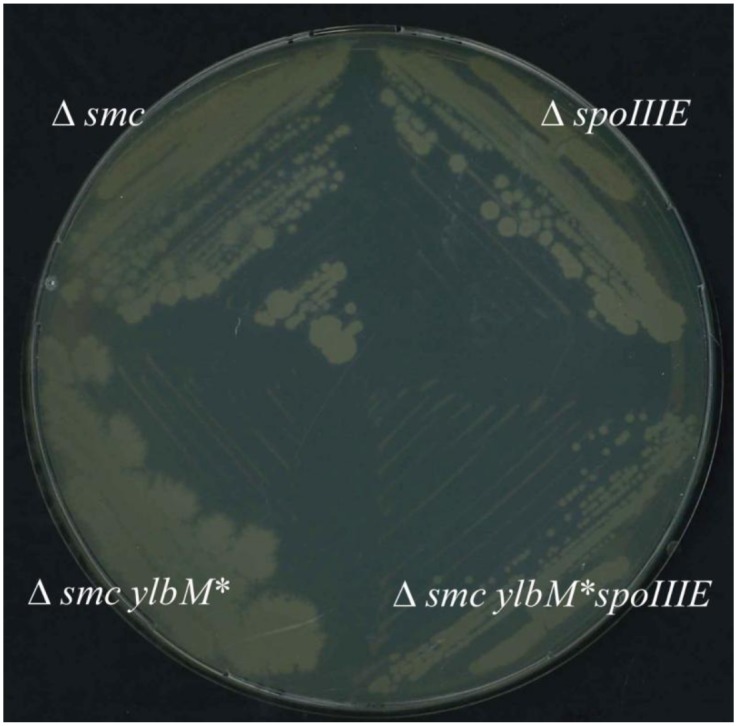
growth of the spoIIIE mutant strains.Δsmc cells carrying or not suppressive mutation were combined with the spoIIIE deletion. The combination of the two deletion could only be obtain when suppressive mutation is present in the strain. Cells were grown on LB plates incubated at permissive (23°C).